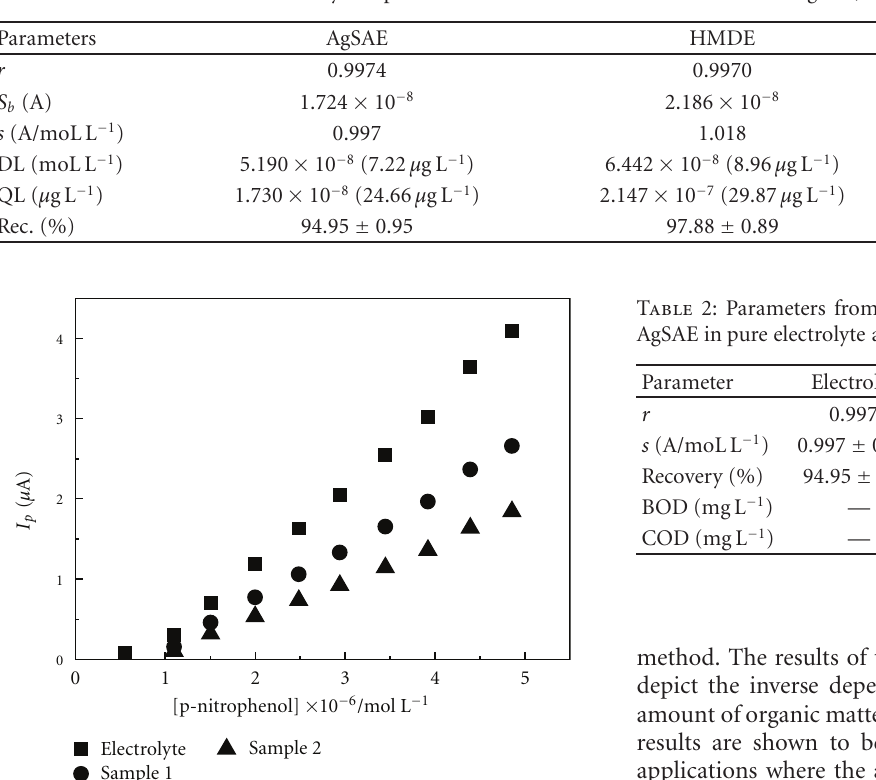
Table 1: Analytical parameters for the determination of 4-NP on AgSAE, HMDE, and AgE.